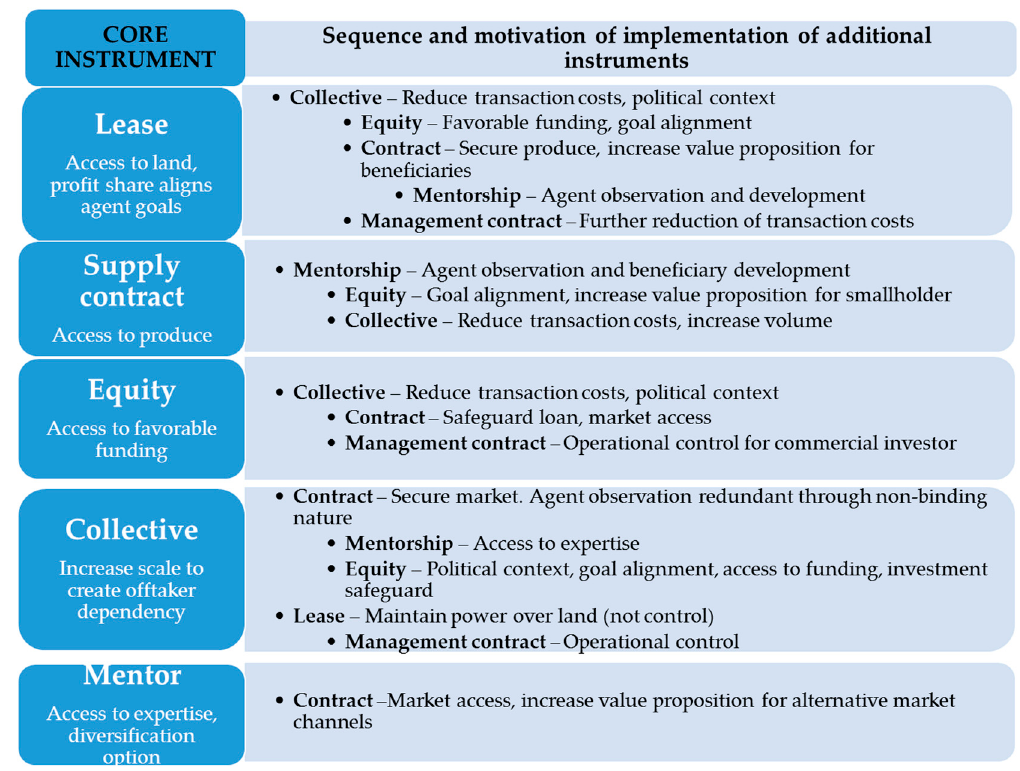
Figure 2. Core instrument and motivation for additional tools according to theoretical framework.